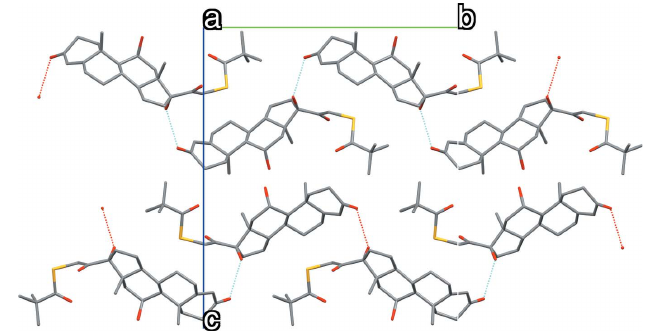
Figure 3 View of the hydrogen bond-network in polymorph ( I ).